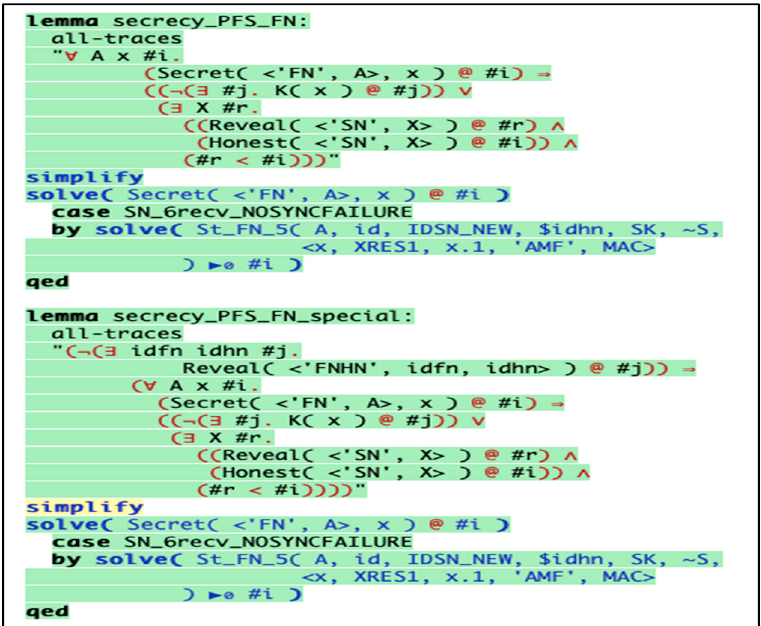
Figure 12. Replay attack resistance in FN . Sensors 2020 , 20 , x FOR PEER REVIEW